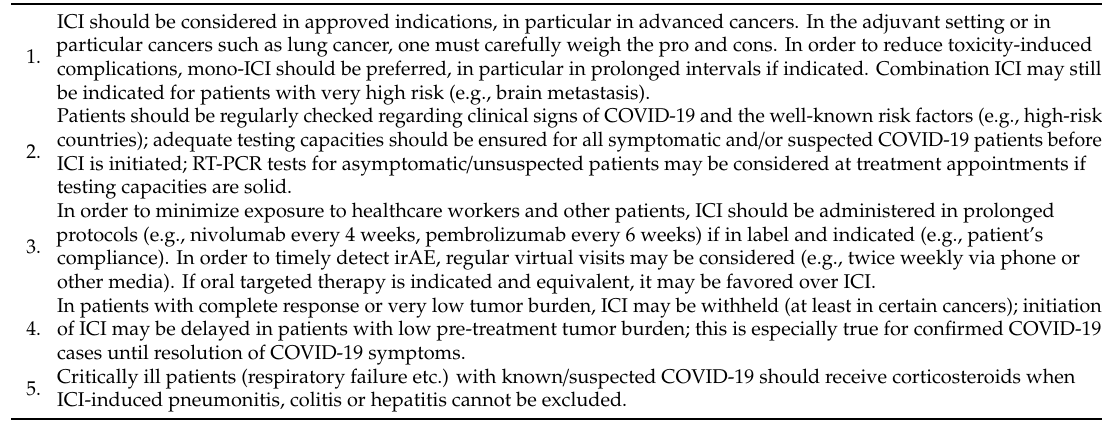
Table 1. General recommendations for the use of immune checkpoint inhibitor (ICI) therapy for cancer patients in the era of COVID-19